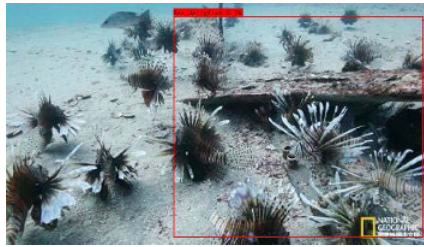
Fig. 7. Detection results of the Sebastes on the YOLOX